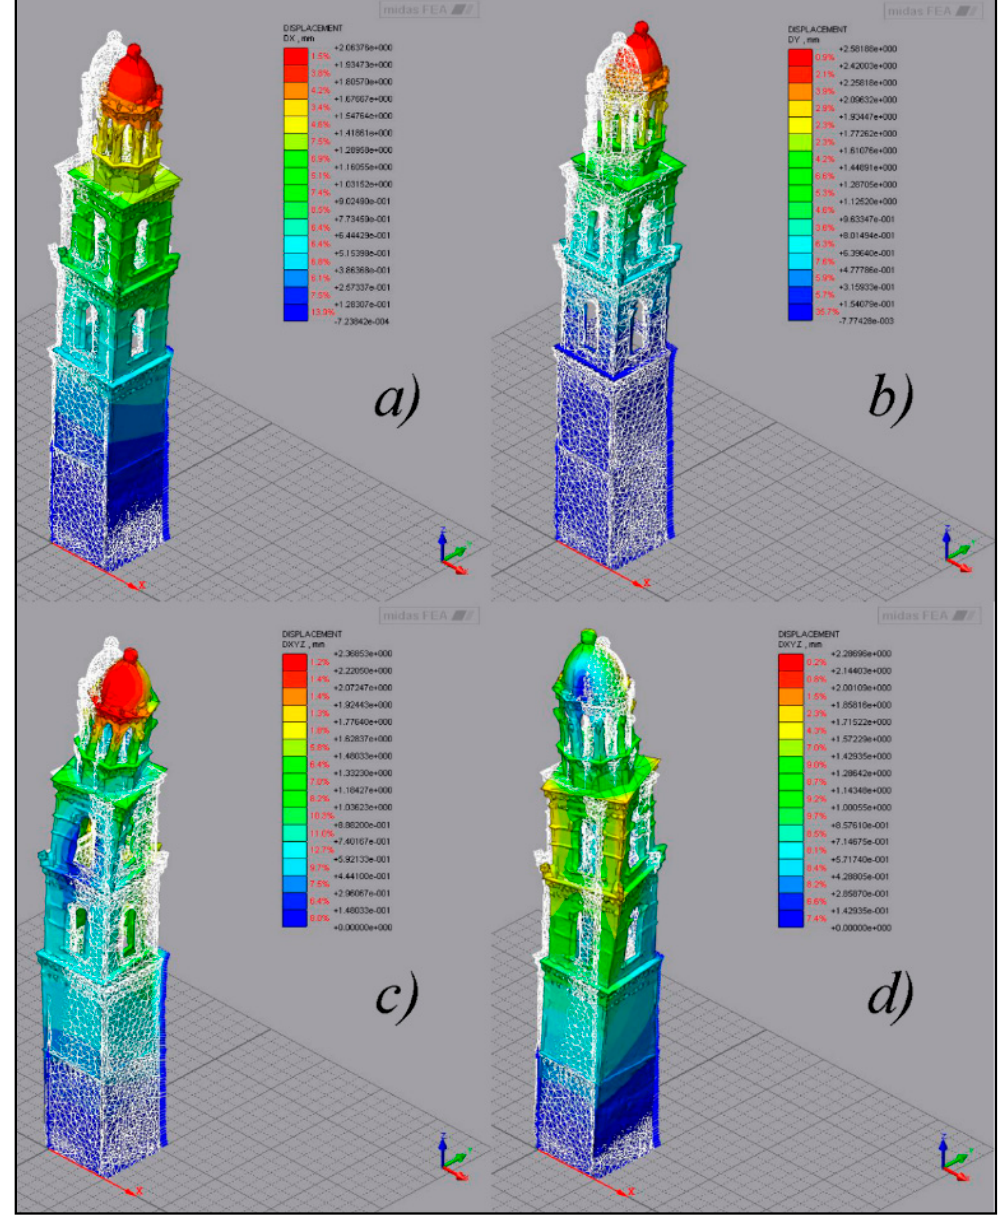
Figure 9. Modal shapes: ( a ) X-translation; ( b ) Y-translation; ( c ) global X-rotation and ( d ) global Z-rotation. Table 2. Masonry properties.